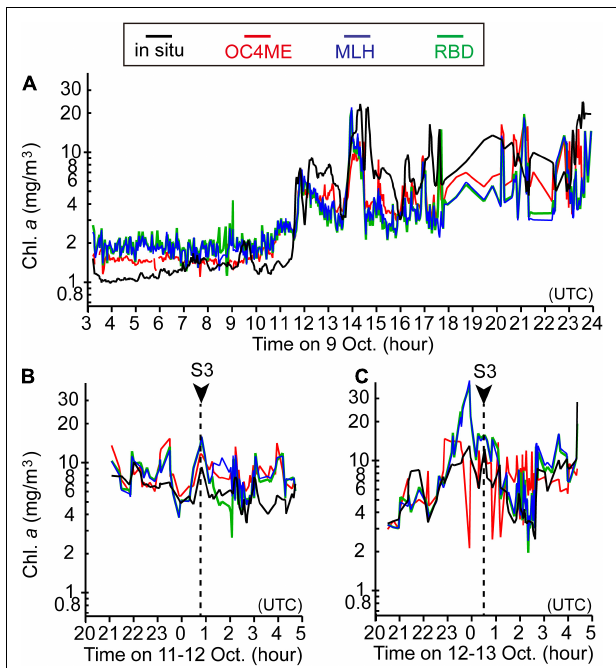
FIGURE 9 | Time series of surface chlorophyll- a concentrations based on in-situ measurements (black lines), maximum band ratio semi-analytical algorithm (OC4ME)-derived estimates (red lines), maximum line height (MLH)-derived estimates (blue lines), and red-band difference (RBD)-derived estimates (green lines) that were corrected by using the regression equations listed in Table 1 . The Sentinel-3 data shown in panels (A–C) correspond to images obtained on 9 October 0029–0032 (UTC), 12 October 0052–0055, and 13 October 0025–0028, respectively. For panels (B,C) , in-situ chlorophyll- a concentrations were compared during the 4 h before or after the Sentinel-3